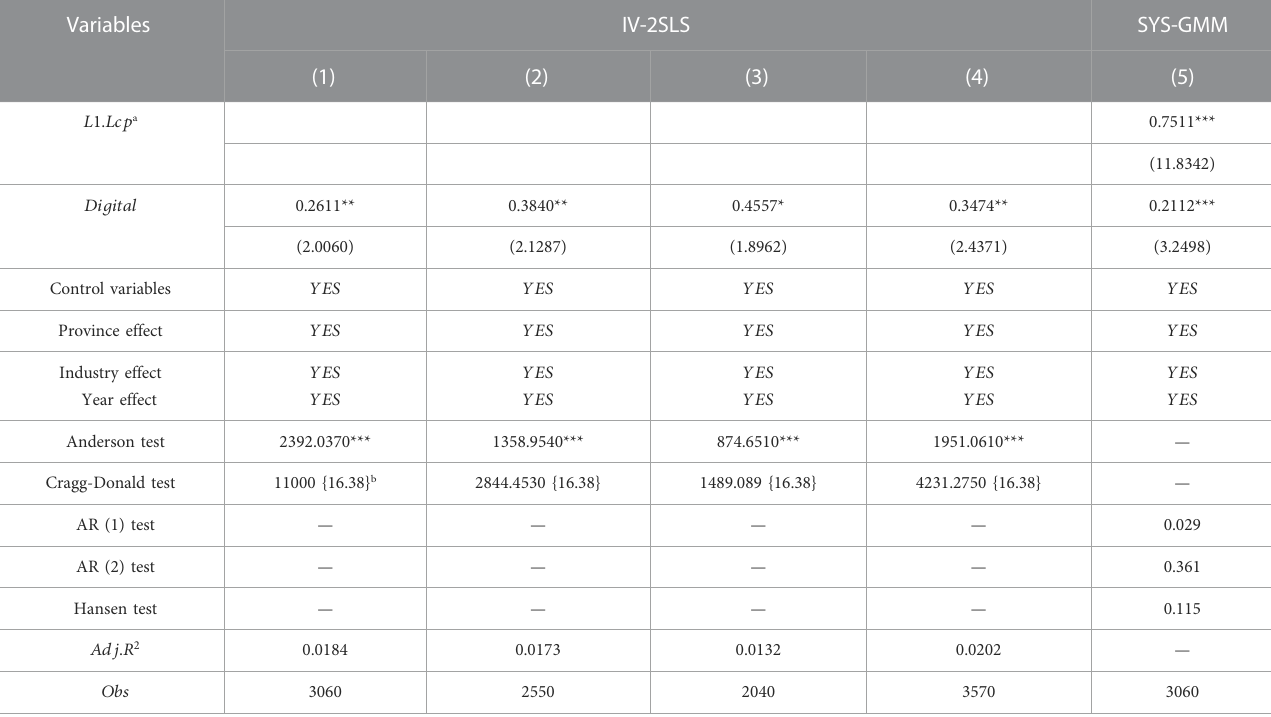
TABLE 7 Results of endogenous treatment. Variables